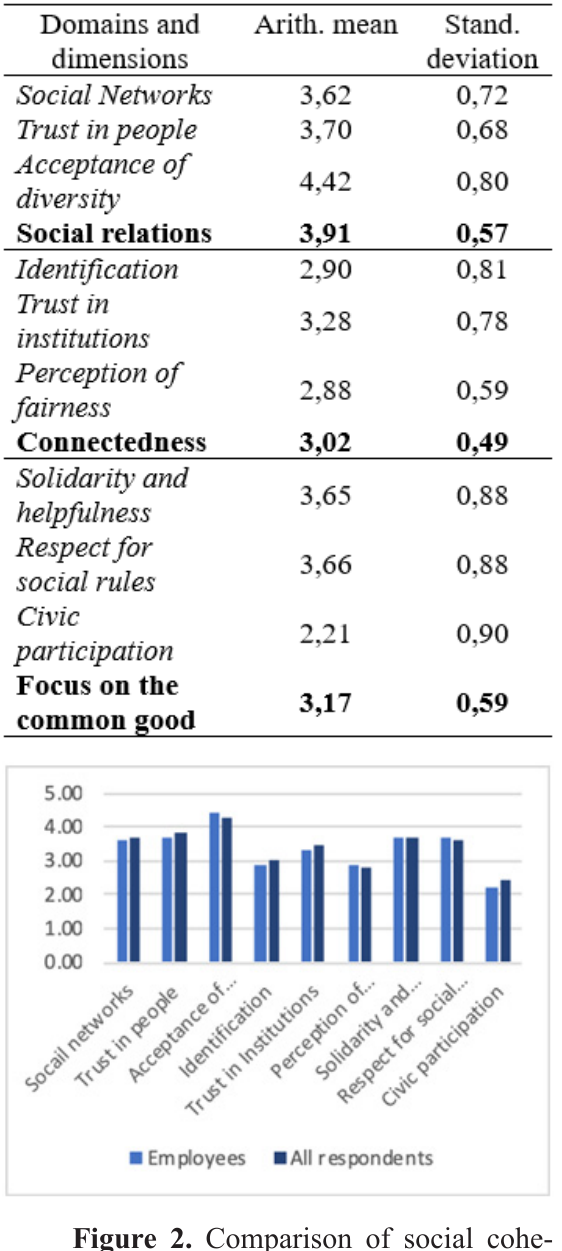
Figure 2. Comparison of social cohe- sion between all respondents and employees by dimensions